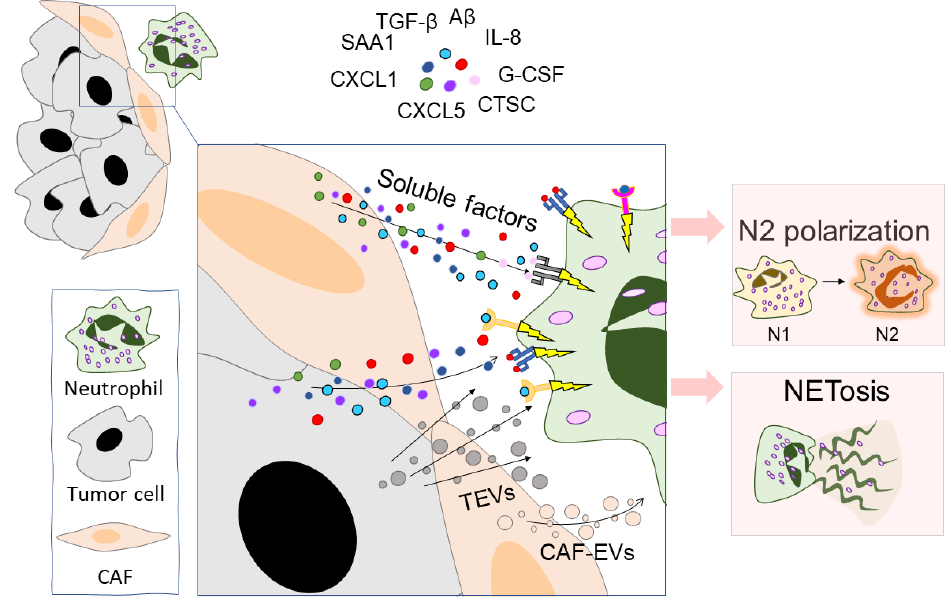
Figure 3. Tumor cells and CAFs modulate neutrophil function. Tumor cells and CAFs